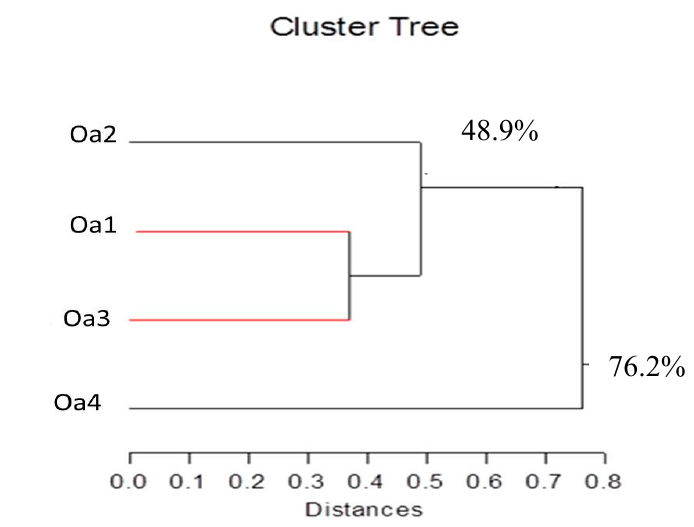
Figure 4. Cluster dendrogram representing genetic relationship among the four accessions of Onopordum